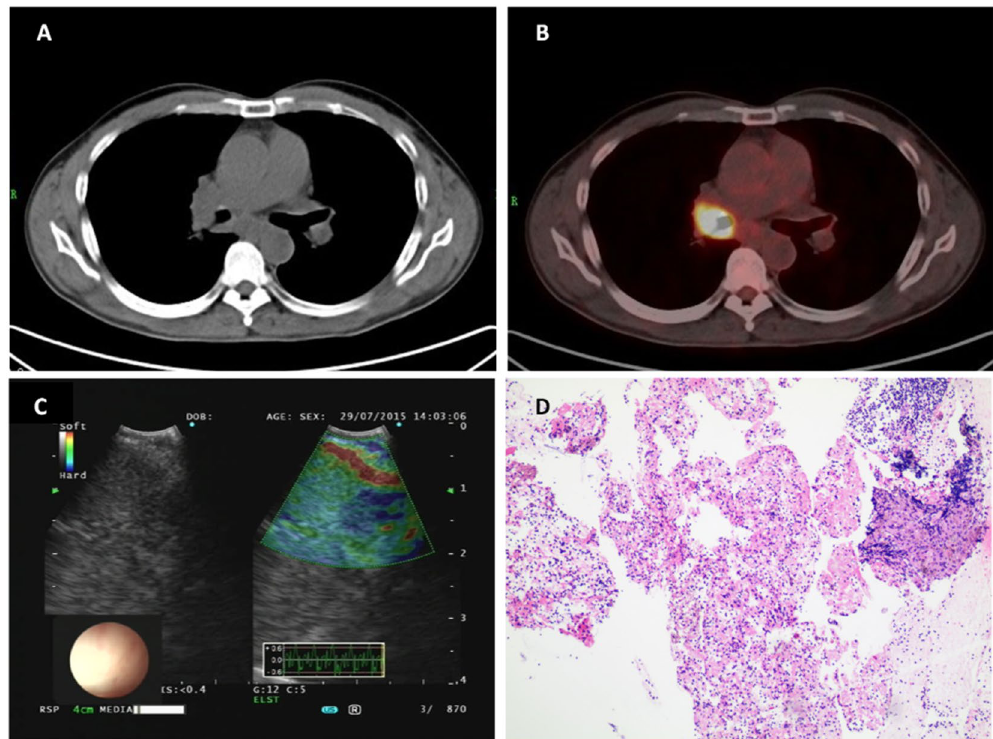
Figure 1. ( A ) representative case of LN with BCP < 36.7% on EBUS elastography imaging. ( A ) A subcarinal LN (#7) measuring 1.5 * 1.3 cm in diameter was shown on CT scan. ( B ) The FDG uptake around the area of right main bronchus, which is the location of the primary tumor, was significantly elevated on FDG-PET/CT, but no significant FDG uptake was shown in the area of the subcarinal LN (#7). ( C ) EBUS elastography showed a prodominantly non-blue (82%, mainly green) area. ( D ) Histopathological diagnosis of EBUS-TBNA specimen was normal lymphatic tissue (hematoxylin–eosin stain, 100). LN, lymph